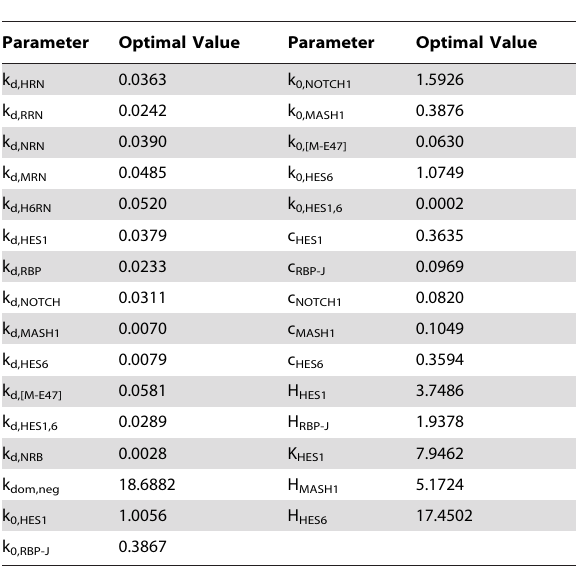
Table 2. Optimal parameter values.